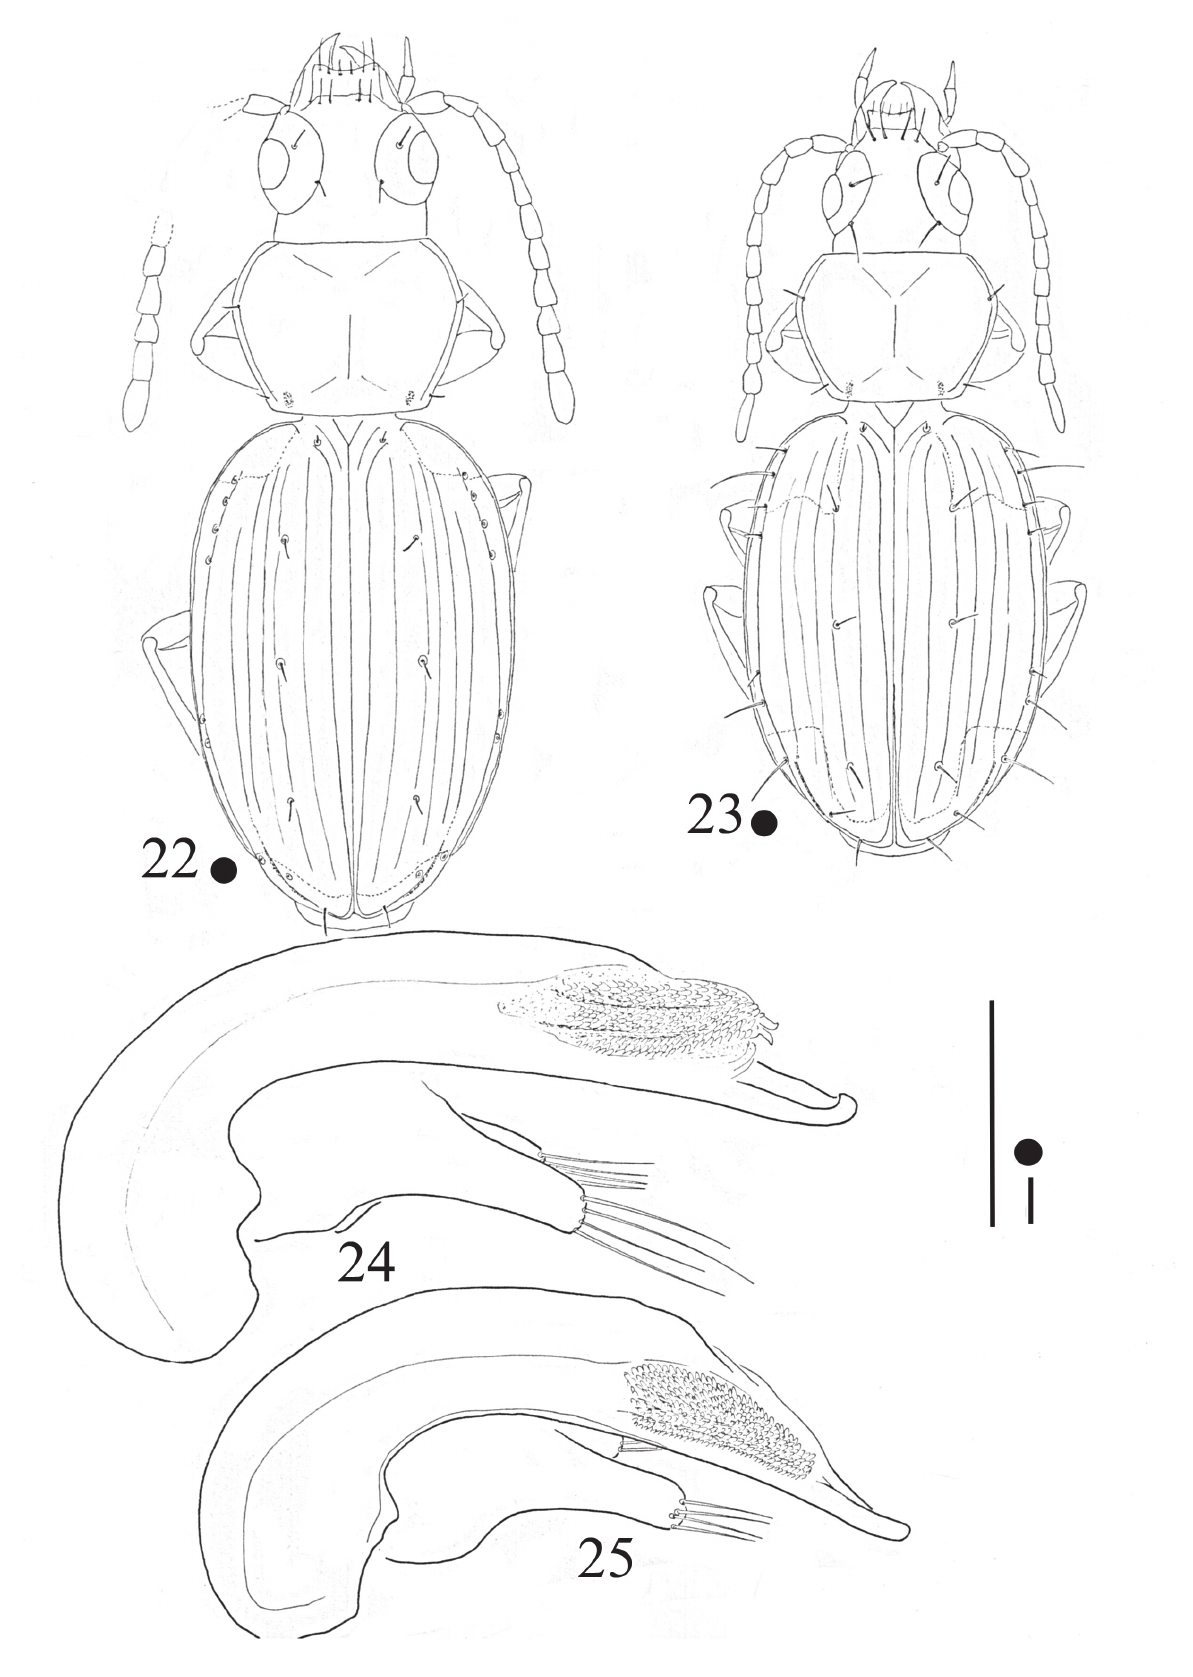
Figs 22-25. Habitus (22, 23) and aedeagus in lateral view (24, 25) of Tasmanorites spp.: 22, 24) T. brevinotatus (Sloane), HT ♂ from Great Lake; 23, 25) T. beatricis sp. nov., HT ♂ from Cradle Mts. Scale: 0.2